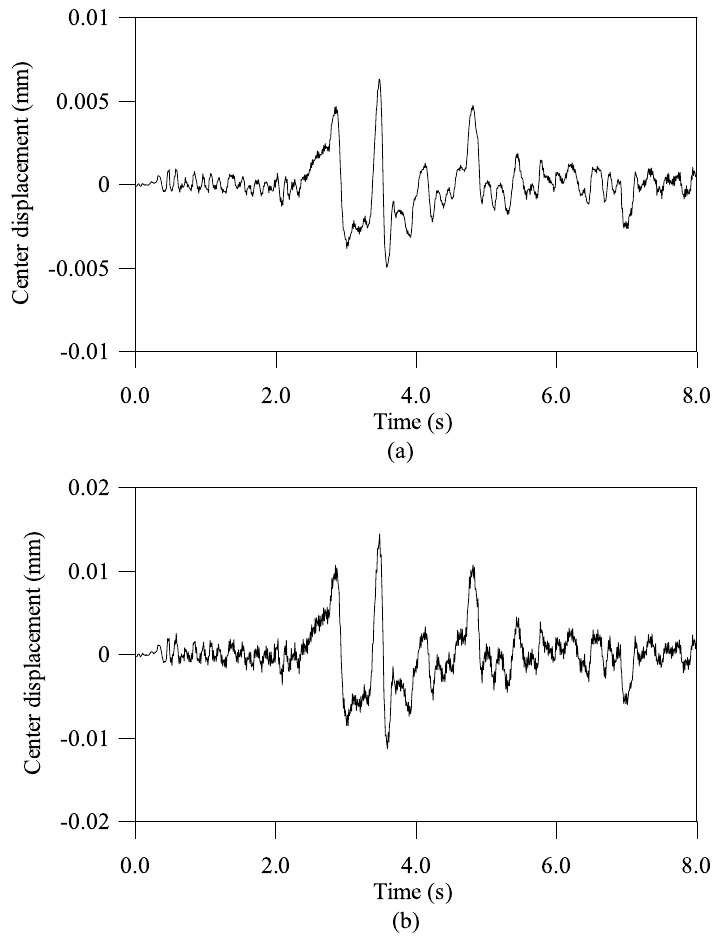
Fig. 6. The time history of the center displacement of the thick clamped plate for (a) b/a = 1.0 and t/a = 0.2, and (b) b/a = 2.0 and t/a = 0.2. the long span, the y axis, direction. As also seen from this figure, in general, the effects of the changes in the thickness/span ratios on the absolute maximum bending moment, M y , are larger than the changes in the aspect